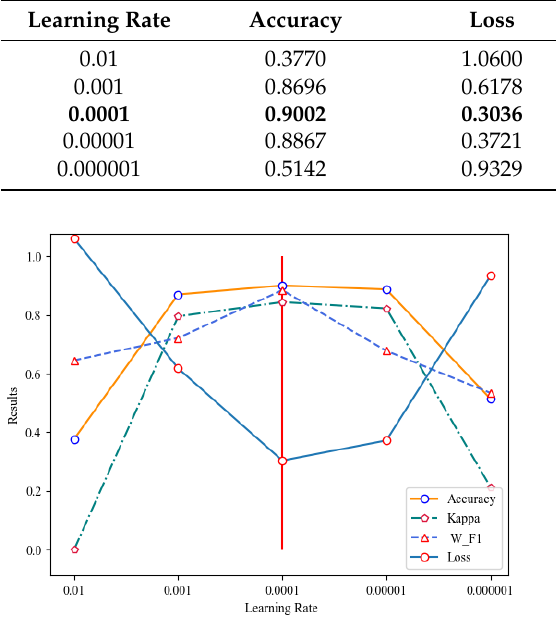
Figure 10. Selection of learning rate. Table 6. Selection of learning rate.